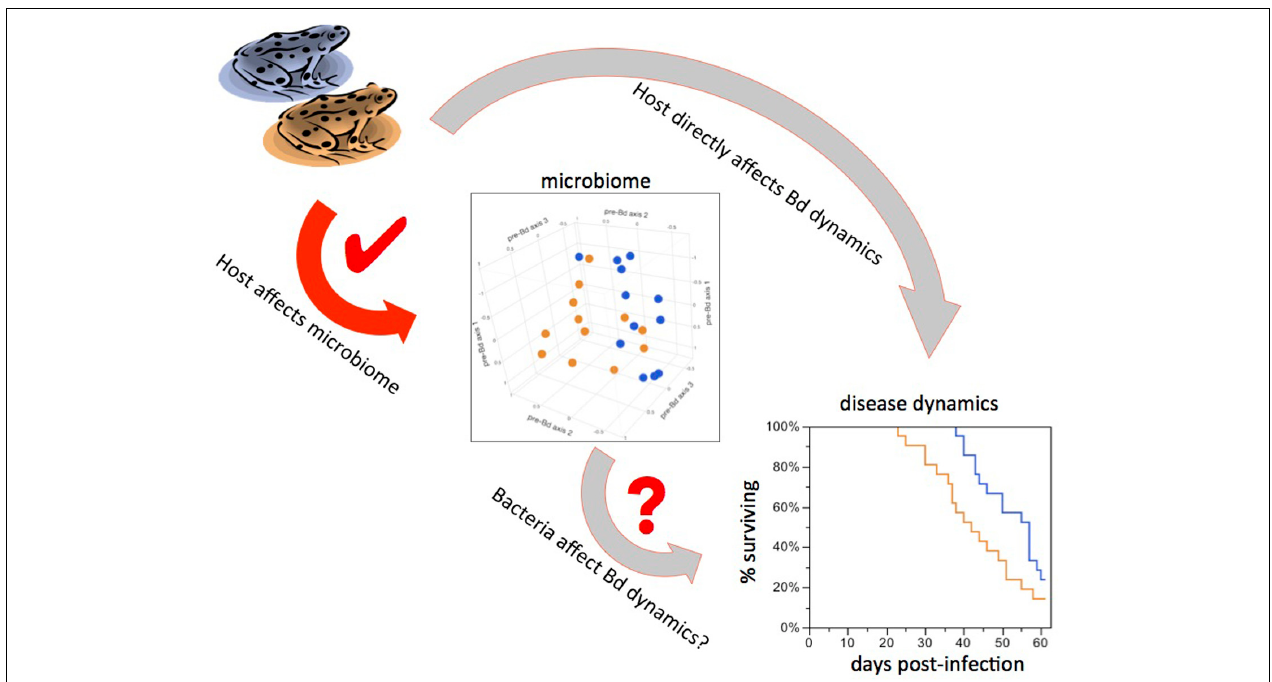
FIGURE 5 | Teasing apart cause from correlation. Possible causal links between experimental treatments and Bd infection outcomes. Frog sources led to different bacterial communities and differences in downstream Bd dynamics (red arrow). This could mean that bacteria mediate disease dynamics (short gray arrow). It is also possible that the host influences both the microbiome and disease dynamics independently of each other (long gray arrow), such that the variation in bacteria is not the driver of differences in Bd